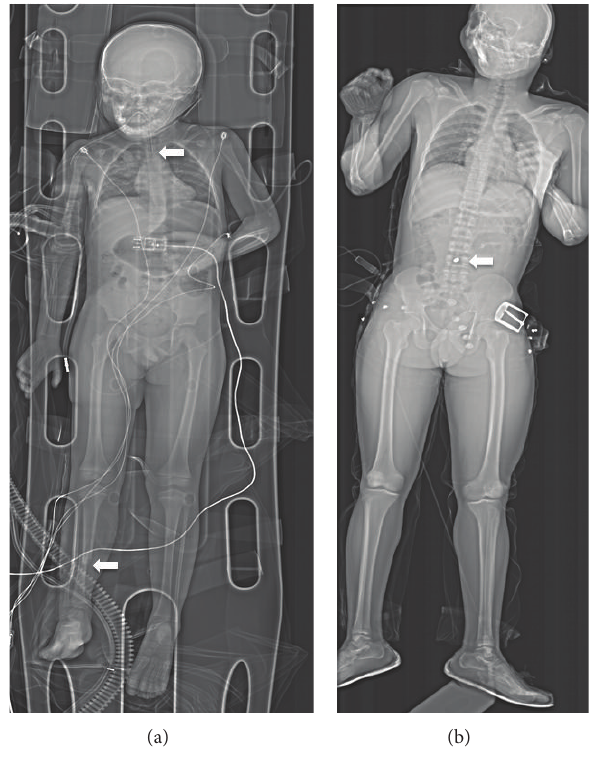
Figure 3: (a) LS X-ray of a paediatric patient showing fractured tibia/fibula and verification of chest intubation and (b) LS of an adult male showing gunshot wound to the